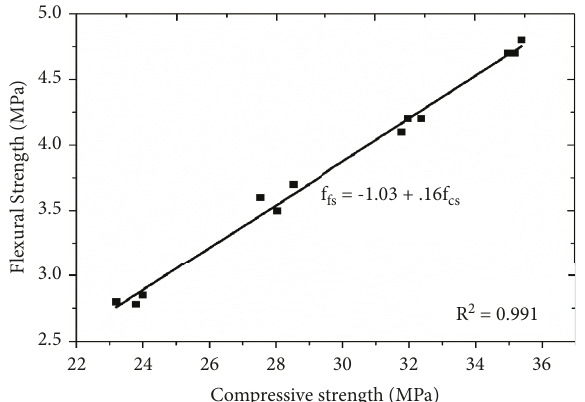
Figure 10: Graph of correlation between compressive strength and flexural strength.